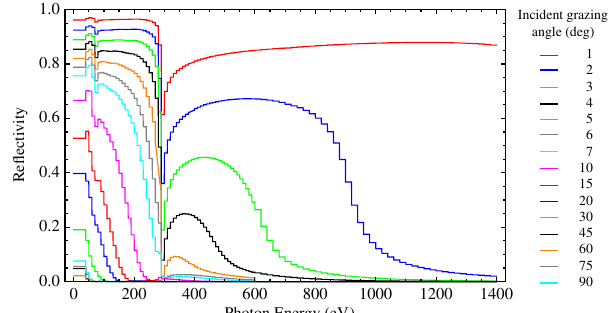
FIG. 1. Smooth surface photon reflectivity R for a 10 nm C film on Al substrate [15].